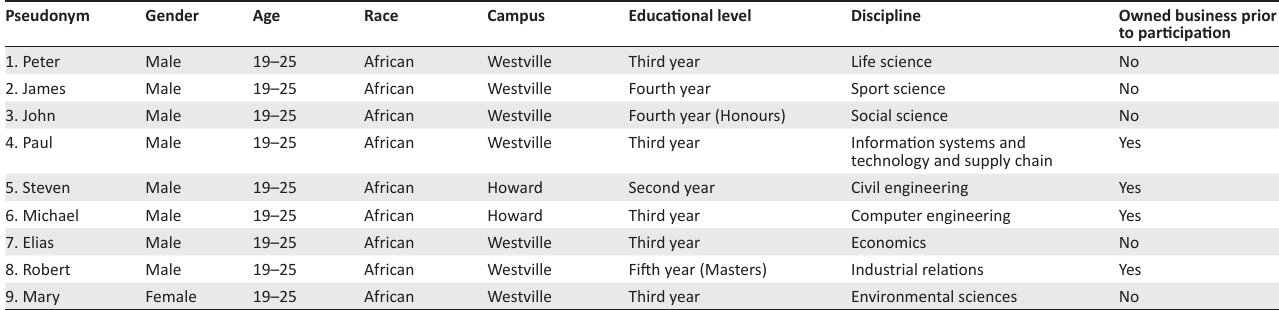
TABLE 1: Profiles of the